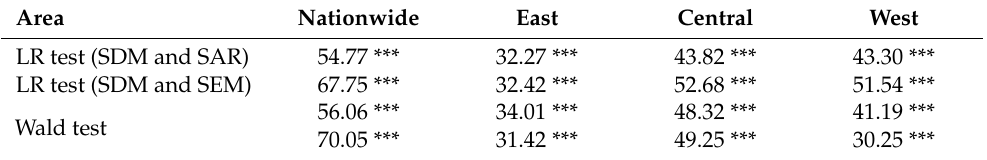
Table 4. LR test and Wald test